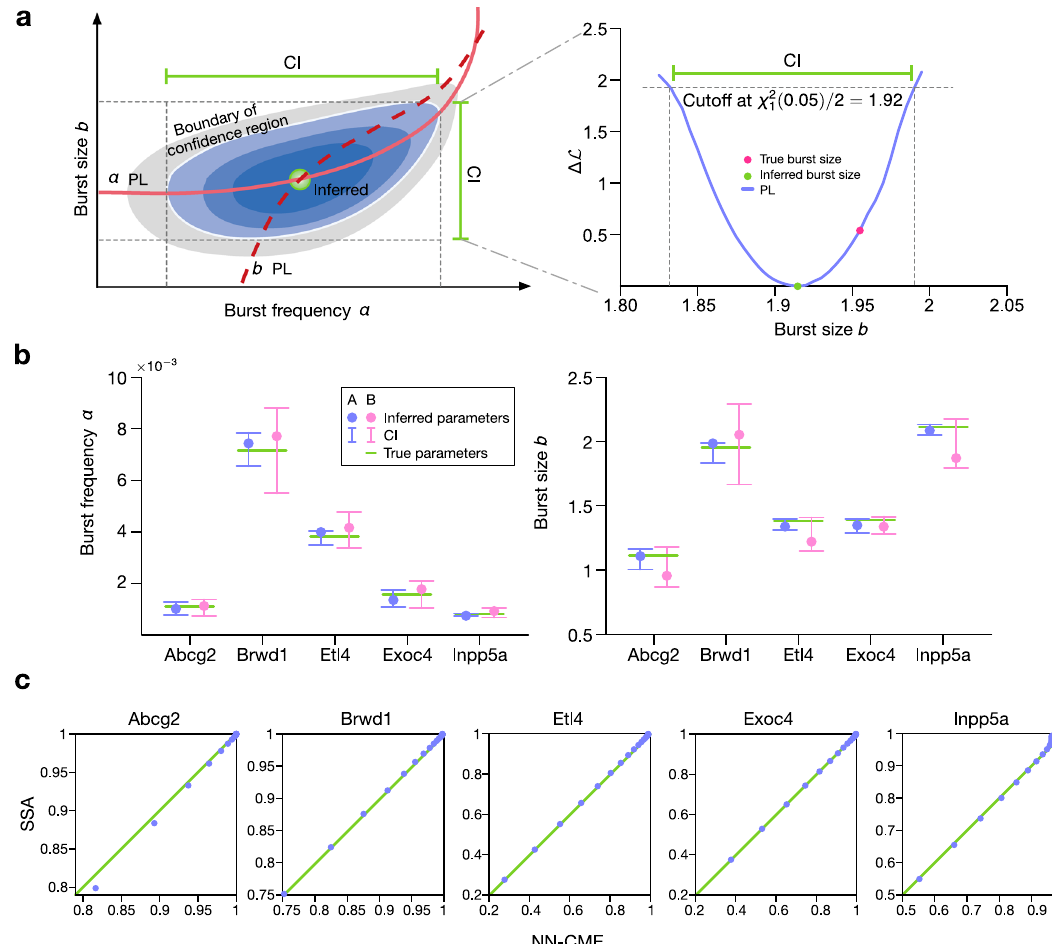
Fig. 7 ANN-aided model approximation seamlessly integrates the inference of kinetic parameters and approximation of the delay CME by a NN-CME. The unknown kinetic parameters can be treated in the same way as neural-network coef fi cients (weight and biases) and optimized to minimize the objective function. Application to Model II. a Sketch of the computation of the 95% con fi dence interval (CI) of the inferred kinetic parameters. Blue areas indicate the 95% con fi dence region, while the grey area shows the non-con fi dence region. Both solid and dashed red lines show the pro fi le likelihoods (PLs) of burst frequency α and burst size b , respectively (See SI Note 8 for details). b Inferred values of α and burst size b (dots), their 95% CIs (error bars) and the true values (green lines) for fi ve mammalian genes. Inference by using ANN-aided model approximation is robust against size of dataset: Dataset A (blue, 100 snapshots and 10 4 cells) and Dataset B (red, 50 snapshots and 10 3 cells) produce similar results. c Quantile – quantile plots for the steady-state distributions of the NN-CME and those obtained from the SSA; the linearity con fi rms that the ANN-aided model approximation can accurately approximate the distribution using the NN-CME even when the optimization is over both the kinetic parameters and the neural-network coef fi cients. The rate constants and other parameters related to the ANN ’ s training are speci fi ed in SI Table